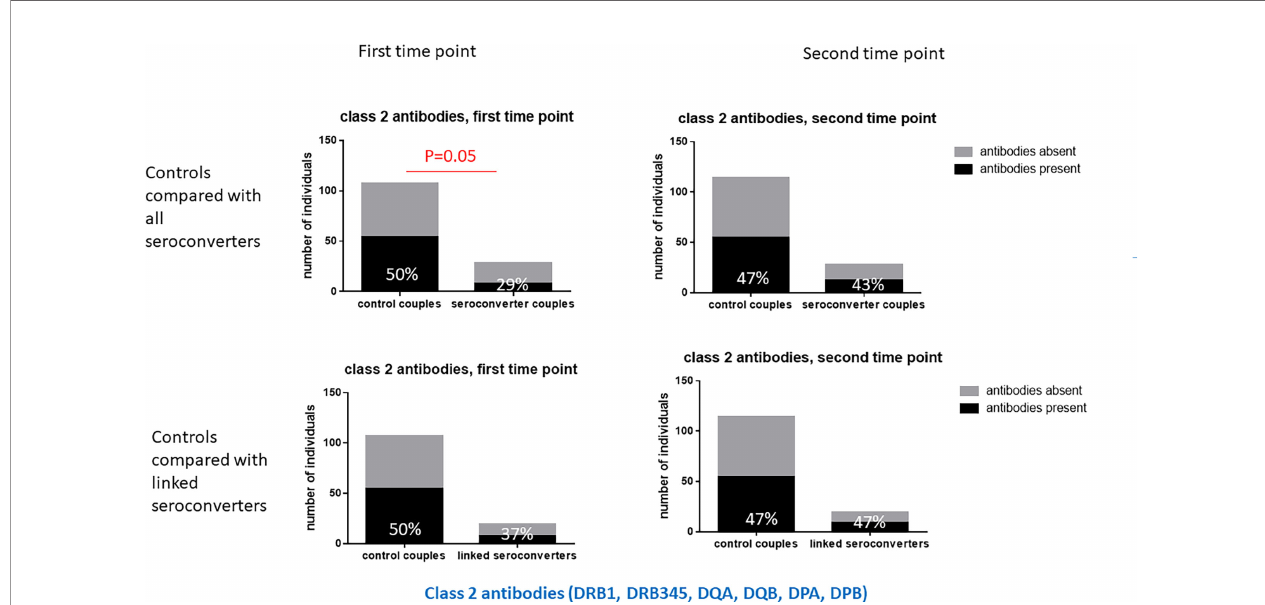
FIGURE 1 | Class 2 HLA antibodies in HIV-seroconverters compared with highly exposed persistently seronegative controls, at the fi rst and second timepoints. Upper panel shows comparison of highly expos ed persistently seronegative controls with all HIV-seroconverter couples. Lower panel shows comparison of highly exposed persistently seronegative controls with only linked HIV-seroconverter couples. At the fi rst timepoint, a signi fi cantly higher proportion of highly exposed persistently seronegative controls than individuals who went on to acquire HIV expressed class 2 HLA antibodies.